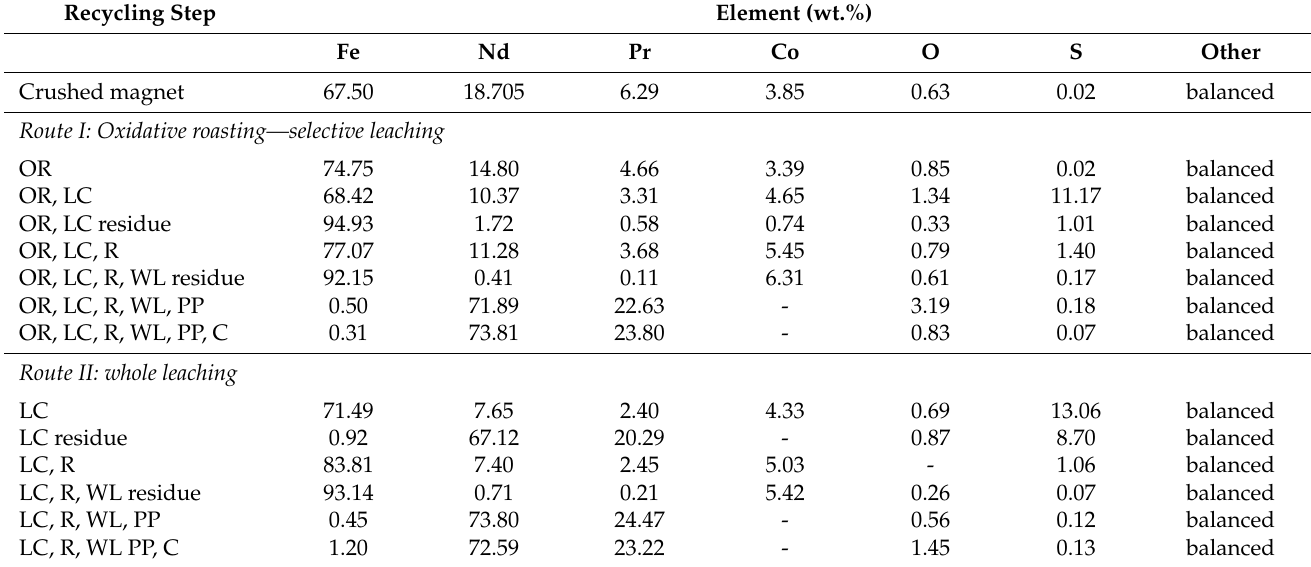
Table 2. The chemical composition of products in various steps of recycling analyzed by